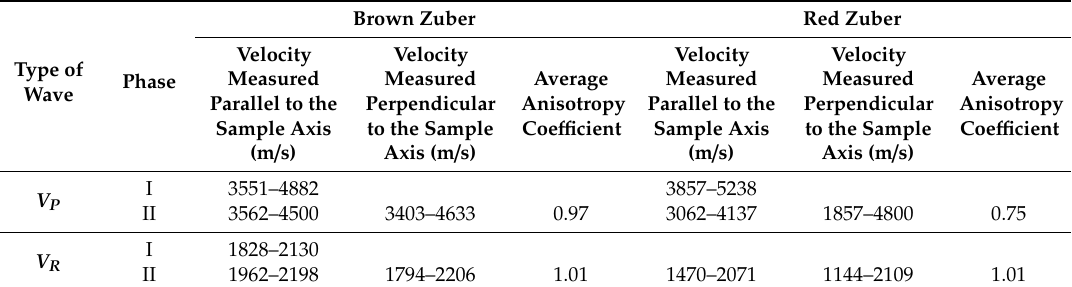
Table 1. Results of the ultrasound testing of the zuber rock samples (according to [57]).